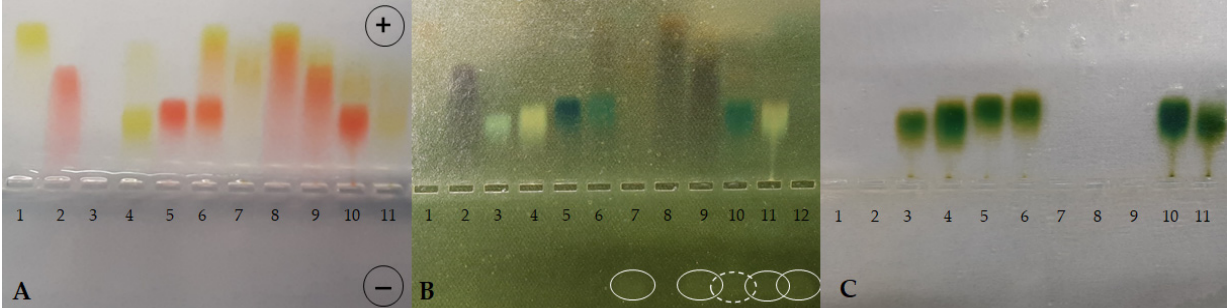
Figure 1. Agarose gel electrophoresis at pH 8.6 of TY, CR, Ag + , BSA and their combinations in different complexes (BSA-TY molar ratio was 1:10 and TY-Ag molar ratio was 1:1.6). ( A ): gel after electrophoresis in a veronal buffer; ( B ): reduction with sodium dithionite locating the presence of excess silver; ( C ): bromophenol blue-stained albumin; BSA free and in the complexes with CR, TY, or TY-Ag and CR-TY-Ag seen as migrating towards the anode; free Ag + seen as migrating towards the cathode: ( 1 ) TY; ( 2 ) CR; ( 3 ) BSA; ( 4 ) BSA-TY (1:10); ( 5 ) BSA-CR (1:10); ( 6 ) BSA-CR-TY (BSA-CR = 1:10 and BSA-TY = 1:10; CR-TY = 1:2) visible additional streak of the complex CR-TY at the front; ( 7 ) TY-Ag (1:1.6); ( 8 ) CR-TY (1:1); ( 9 ) CR-TY-Ag (TY-Ag = 1:1.6); ( 10 ) BSA-CR-TY-Ag (BSA-CR = 1:10, BSA-TY = 1:10, TY-Ag = 1:1.6); ( 11 ) BSA-TY-Ag (BSA-TY = 1:10, TY-Ag = 1:1.6); ( 12 ) Ag + ; (circles mark free silver moving towards the cathode (the dashed line indicates the smallest amount of free silver).